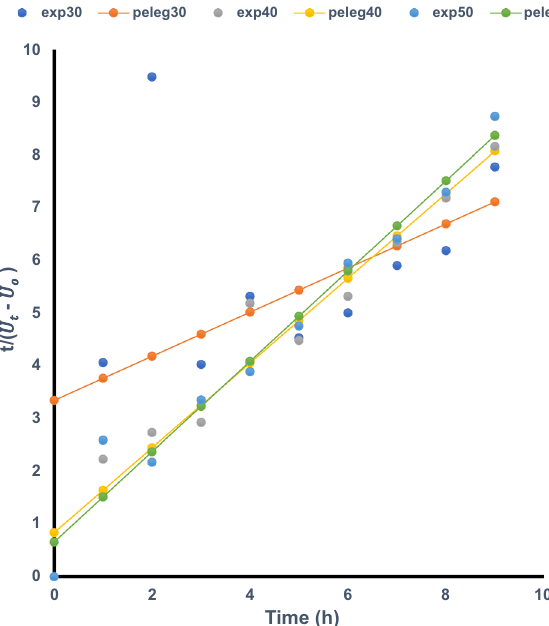
Figure 2. Experimental and Peleg (predicted) water uptake of Mucuna rajada at different temperatures.